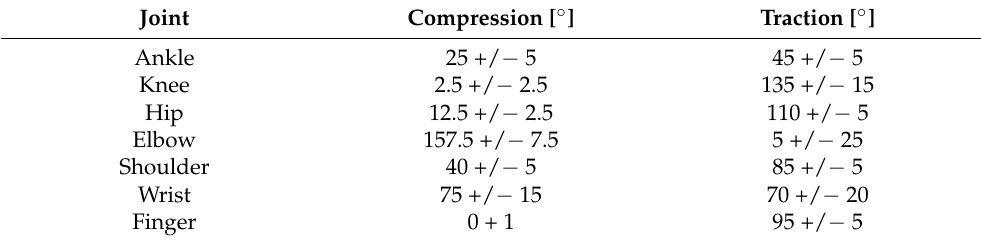
Table 1. Compression and traction maximum angles for human body joints.